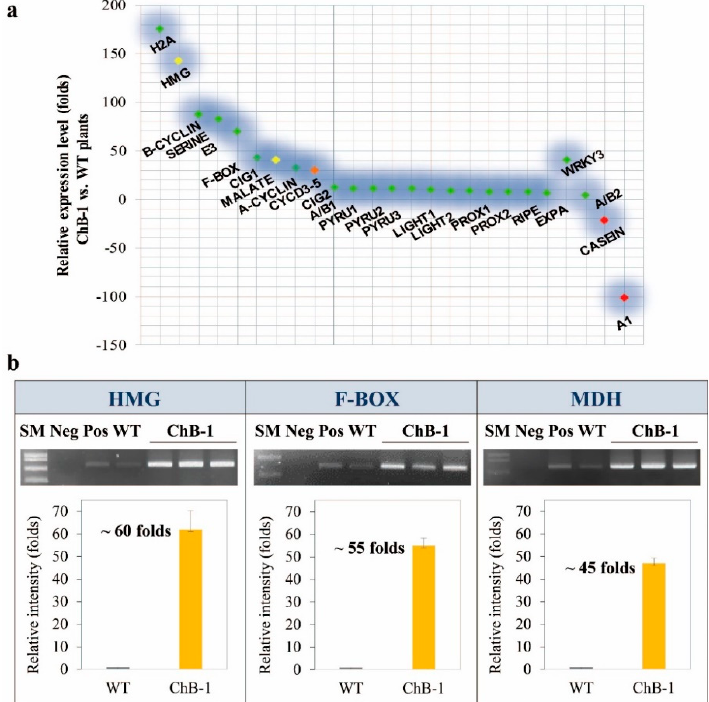
Figure 3. Results of mRNA microarray and mRNA expression levels. ( a ) A summary of the results of mRNA microarray conducted for the relative expression level of genes in the transgenic tobacco plants overexpressing T. maritima BglB targeted to the chloroplasts in comparison with that in the wild-type tobacco plants, indicating that a series of genes was up-regulated, especially high-mobility group (HMG), F-Box, and malate dehydrogenase (MDH). ( b ) The results of mRNA expression levels of HMG, F-Box, and MDH in the transgenic tobacco plants overexpressing T. maritima BglB targeted to the chloroplasts in comparison with those in the wild-type tobacco plants; this assay was conducted by extracting mRNA, generating a cDNA library, and running RT-PCR.